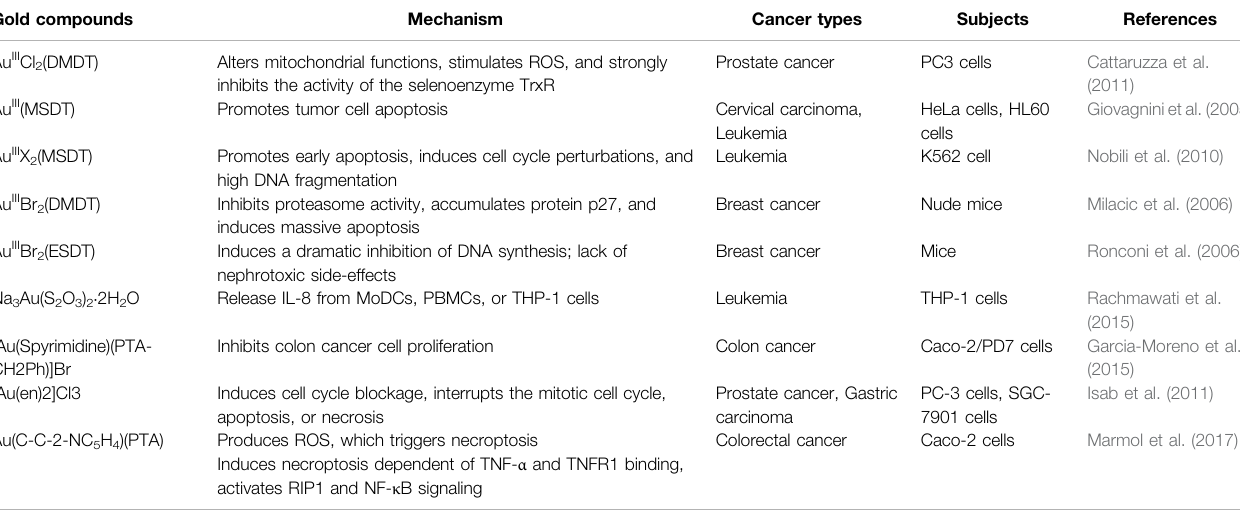
TABLE 1 | Experiments involving gold compounds for cancer